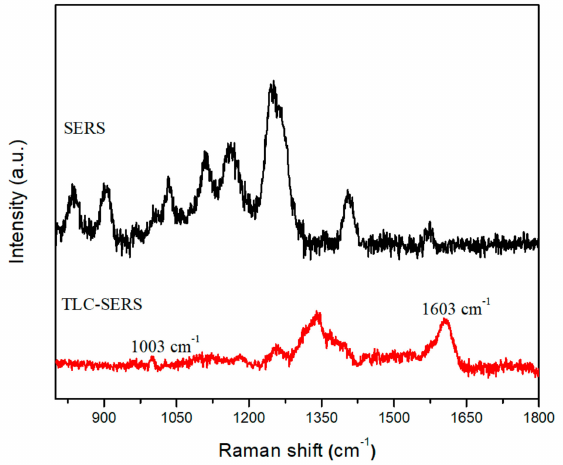
Figure 5. SERS spectra of THC in a marijuana-user urine sample before and after TLC